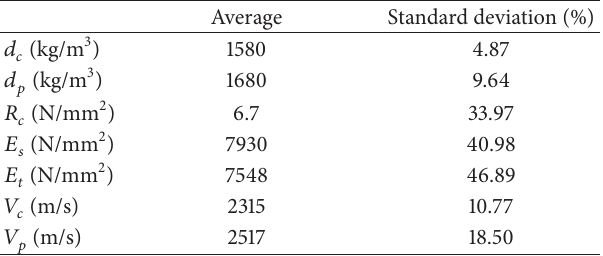
Table 2: Statistical summary of the experimental results. Table 3: Coefficient of correlation 𝑟 between 𝑉 and physical- mechanical